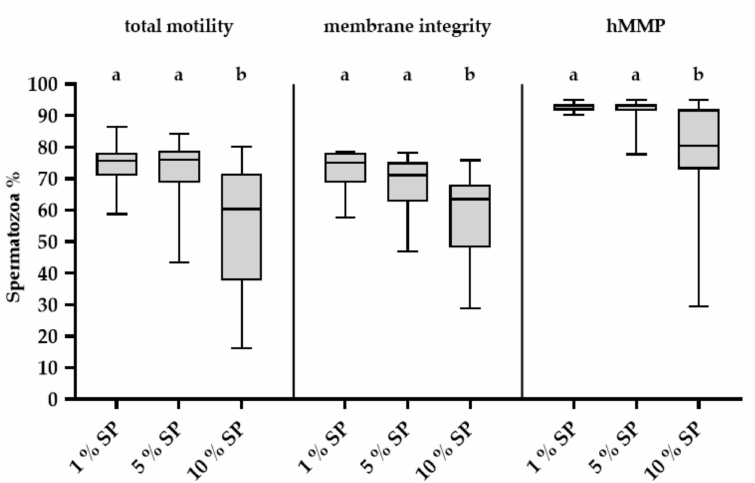
Figure 3. Sperm quality after 144 h of storage in semen doses containing di ff erent concentrations of seminal plasma (SP). Box-whisker plots showing variation in the total motility (%), membrane intact (% propidium iodide negative and peanut agglutinin (PNA) negative) sperm (%), and viable sperm (%) with high mitochondrial membrane potential (hMMP) (propidium iodide negative sperm with J-aggregates). Semen samples contain three di ff erent final concentrations of autologous SP: 1%, 5% and